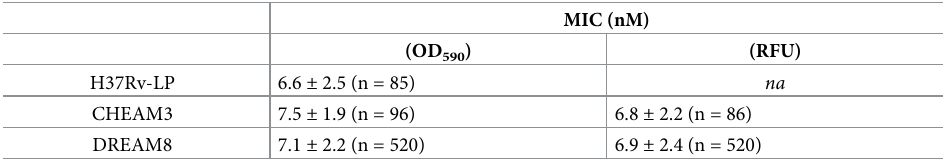
Table 1. Determination of rifampicin activity against recombinant